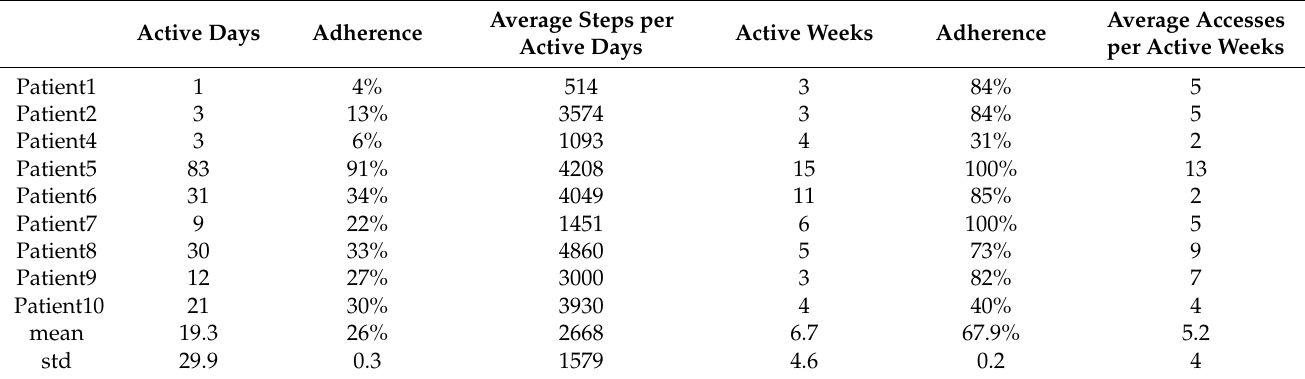
Table 8. vCare steps parameter and active weeks for the IHD